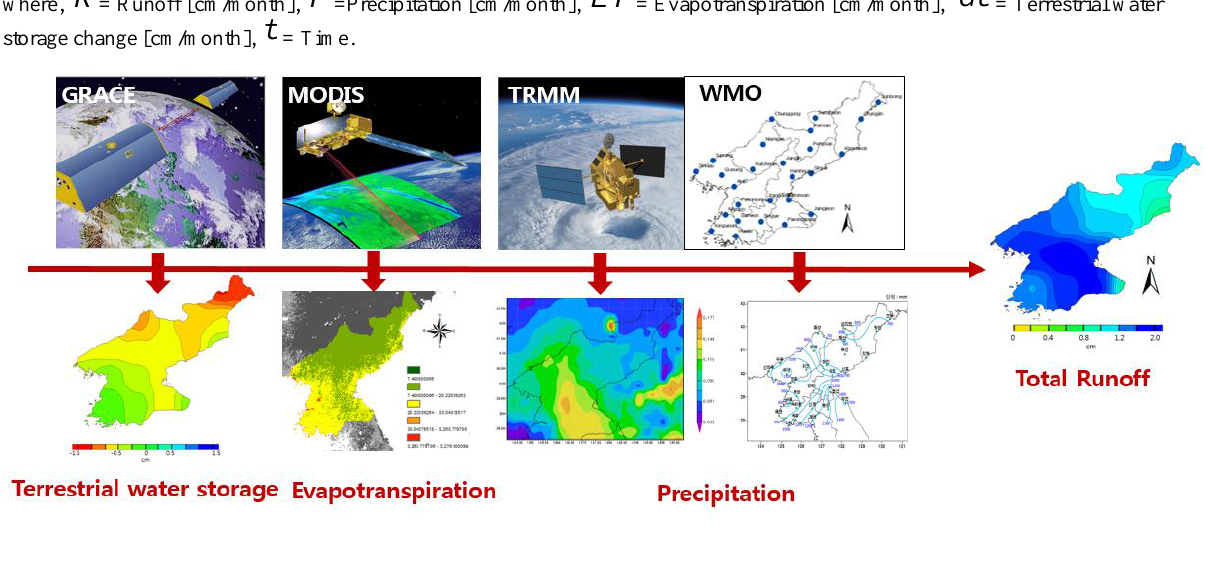
Figure 1. Incorporation of Various Data for Runoff